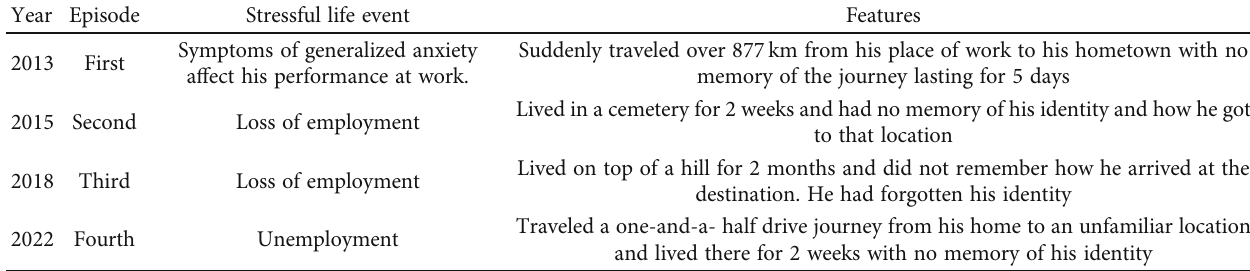
Table 1: The dates, stressful life events associated with, and features of each